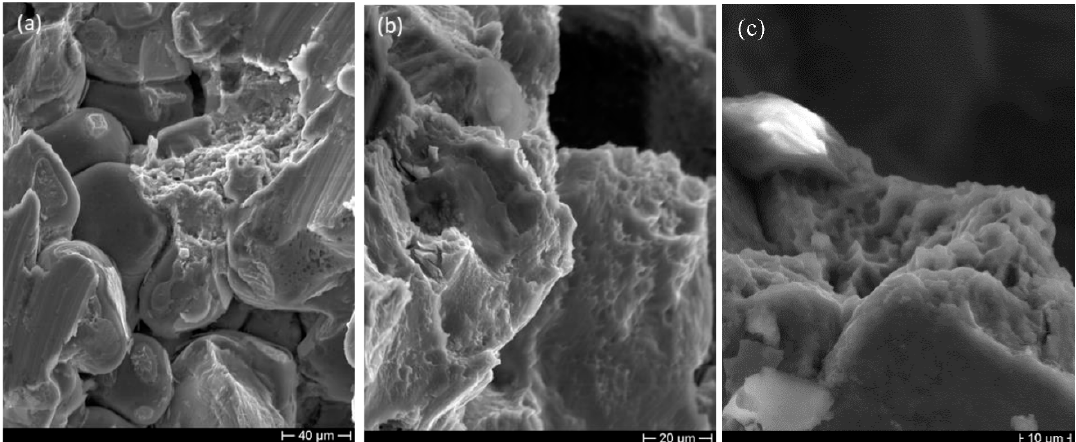
Figure 12. SEM micrographs showing the fracture surfaces close to ( a ) a shrinkage cavity and ( b , c ) in the defect-free area where dimpled surfaces are evident.